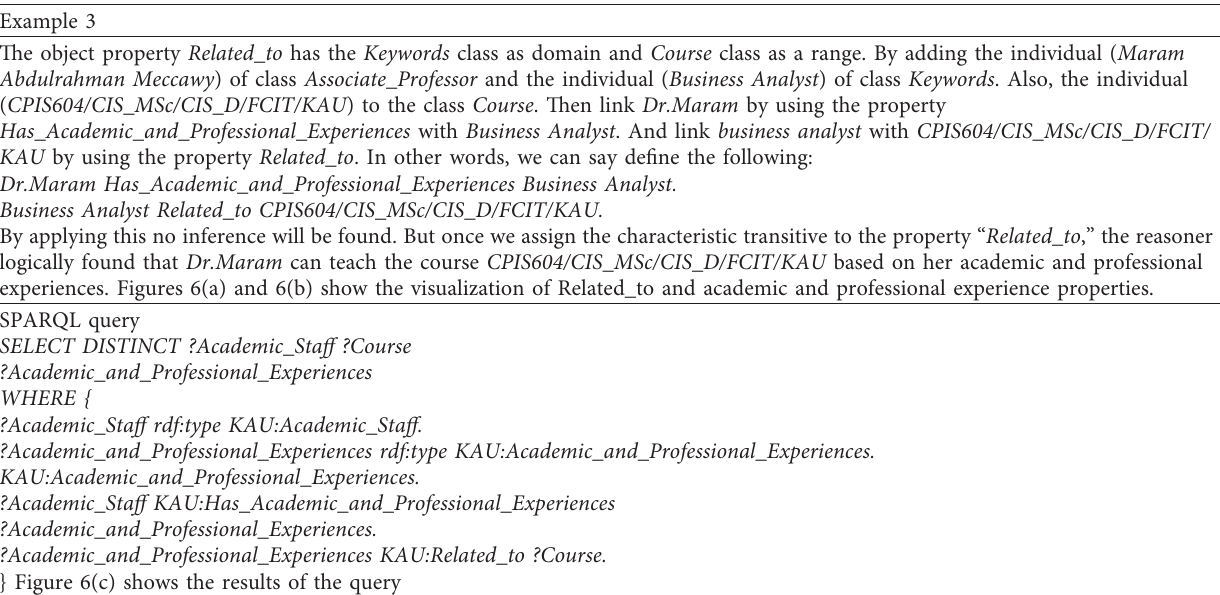
Table 5: The academic and professional experiences